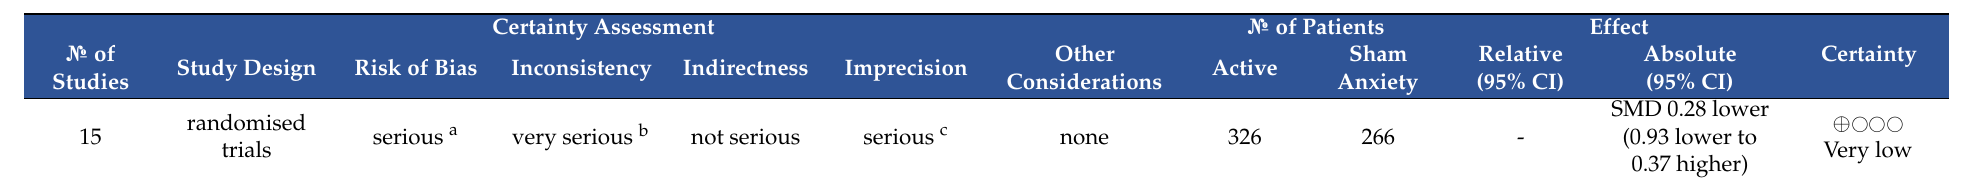
Table 7. GRADE assessment